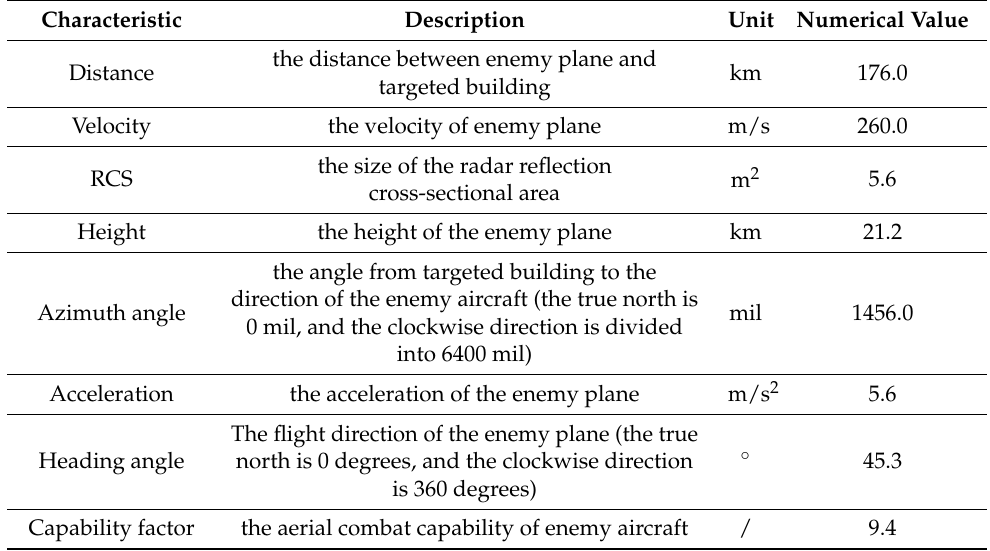
Table 1. Numerical air target intelligence data.